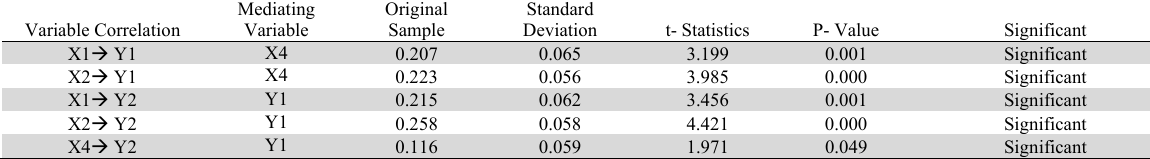
Indirect Effects of Exogenous Variables on Endogenous Variables through Mediation Variables Variable Correlation